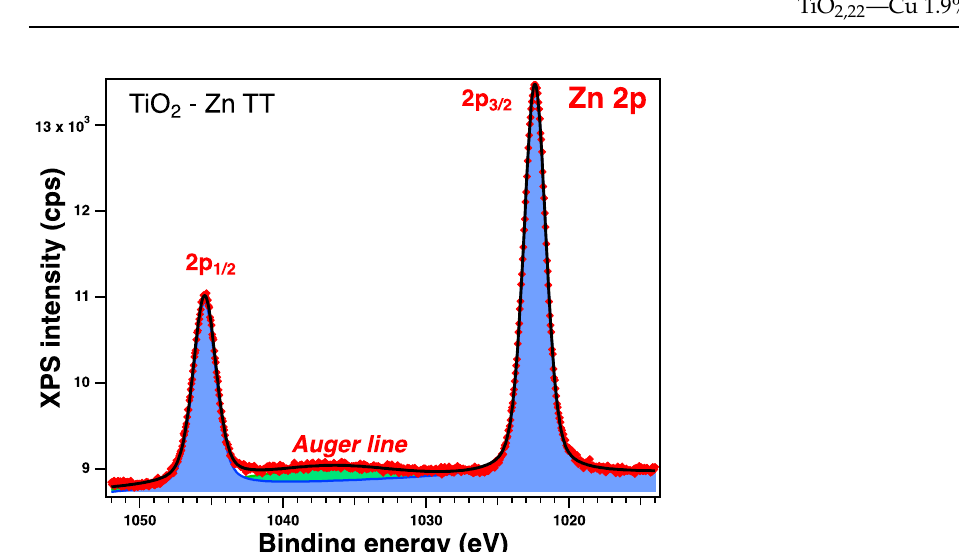
Figure 11. XPS spectra of the Zn 2p level of the thermally treated Zn-doped sample: red symbols for the experimental data, black line for the fit, blue line for C1, and green line for C2, which is an Auger peak.